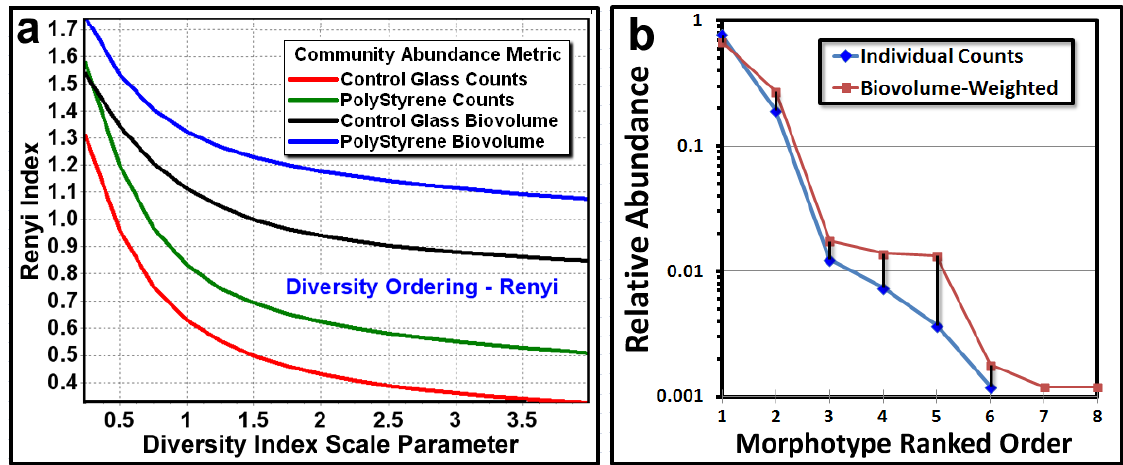
Figure 3. Renyi ordering ( a ) and Whittaker ( b ) ranked abundance plots that compare the diversity of morphotype classes in communities A and B when individual cell counts and biovolume body size are used as the metric of class